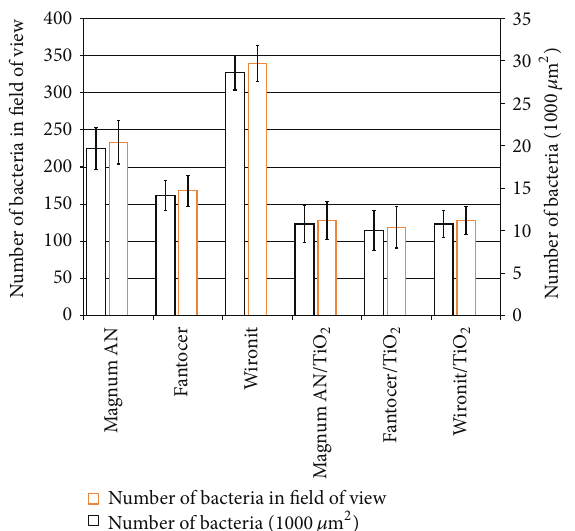
Figure 5: Number of bacteria adhered to the examined sample surfaces.